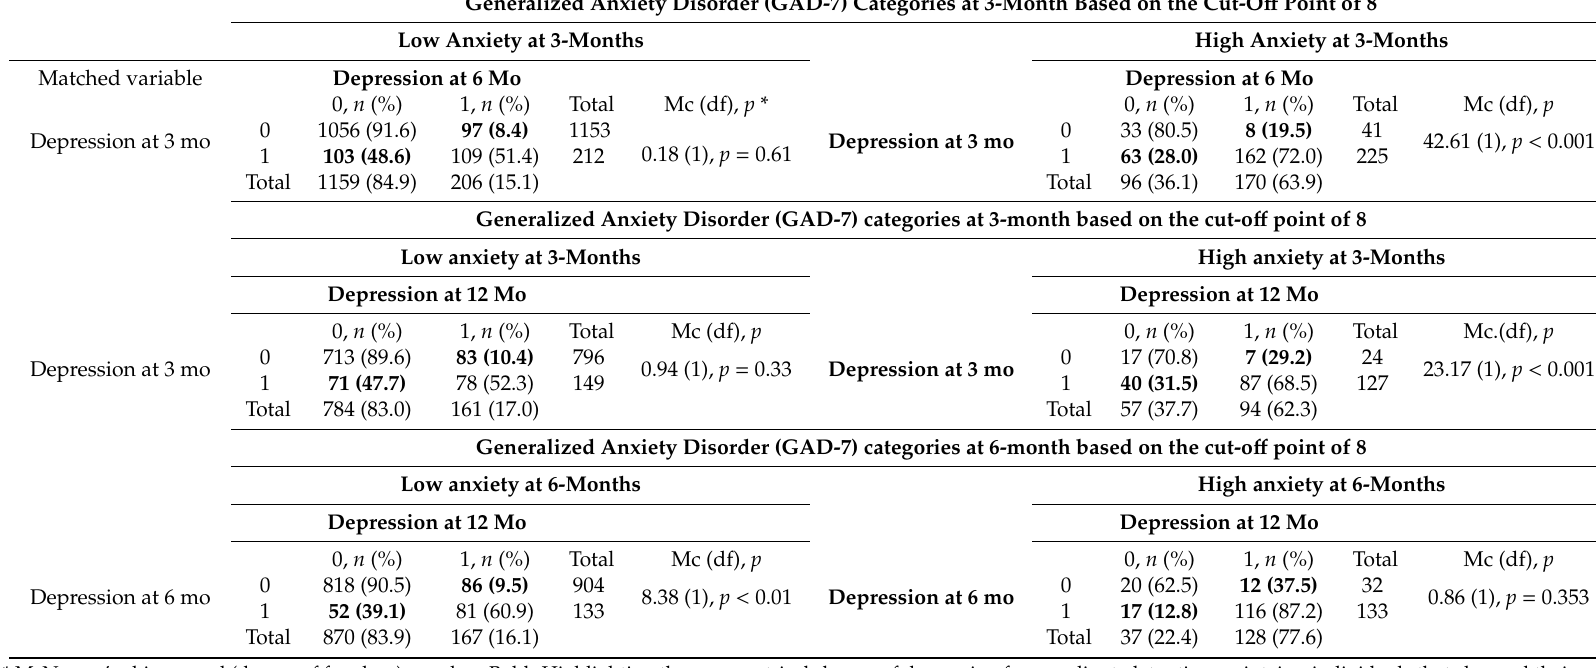
Table 4. The McNemar test statistics (chi-squared) for intra-individuals changes of depression over time in low and high anxiety groups using the McNemar chi-squared